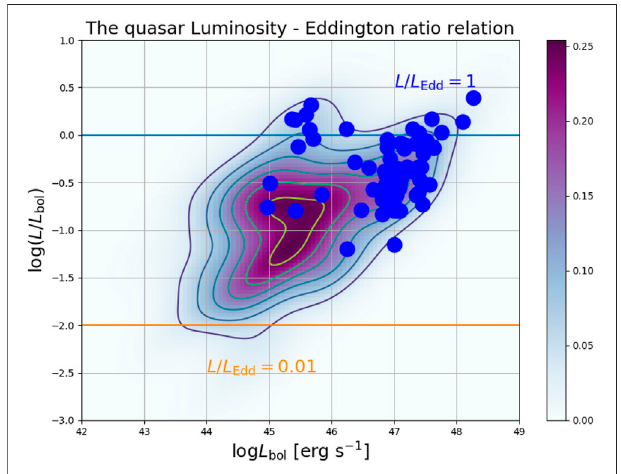
FIGURE 13 | The relation between Eddington ratio L / L Edd and bolometric luminosity for the sample described in Figure 11 , second panel. Quasars occupy the range 0.01 – 1, but only above Eddington ratio ≈ 0.1 large shifts are observed, as shown by the distribution of the blue data points, which represent quasars with the largest [OIII] λλ 4959,5007